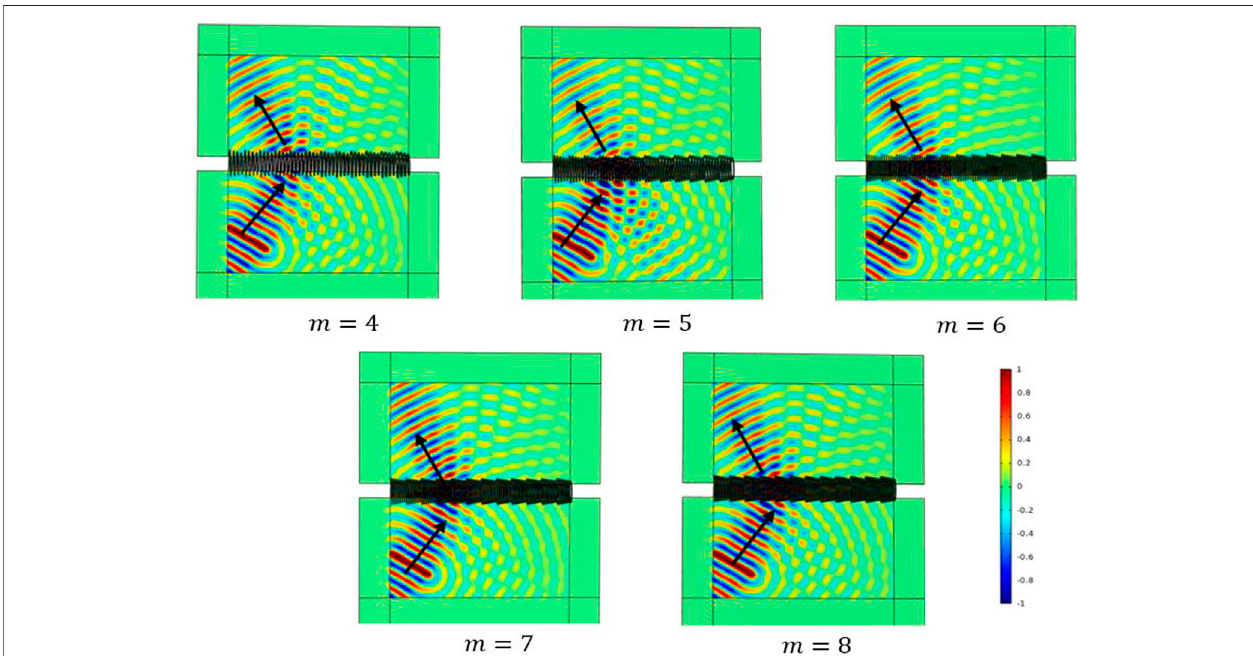
FIGURE 5 | When the incident angle is -30 ° , the corresponding transmission wave fi elds of metasurfaces with different unit cell numbers.